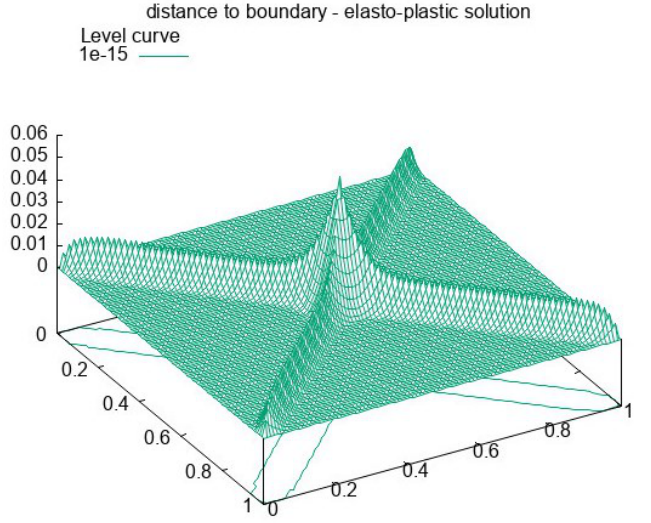
Figure 1. Elastic and plastic regions of the